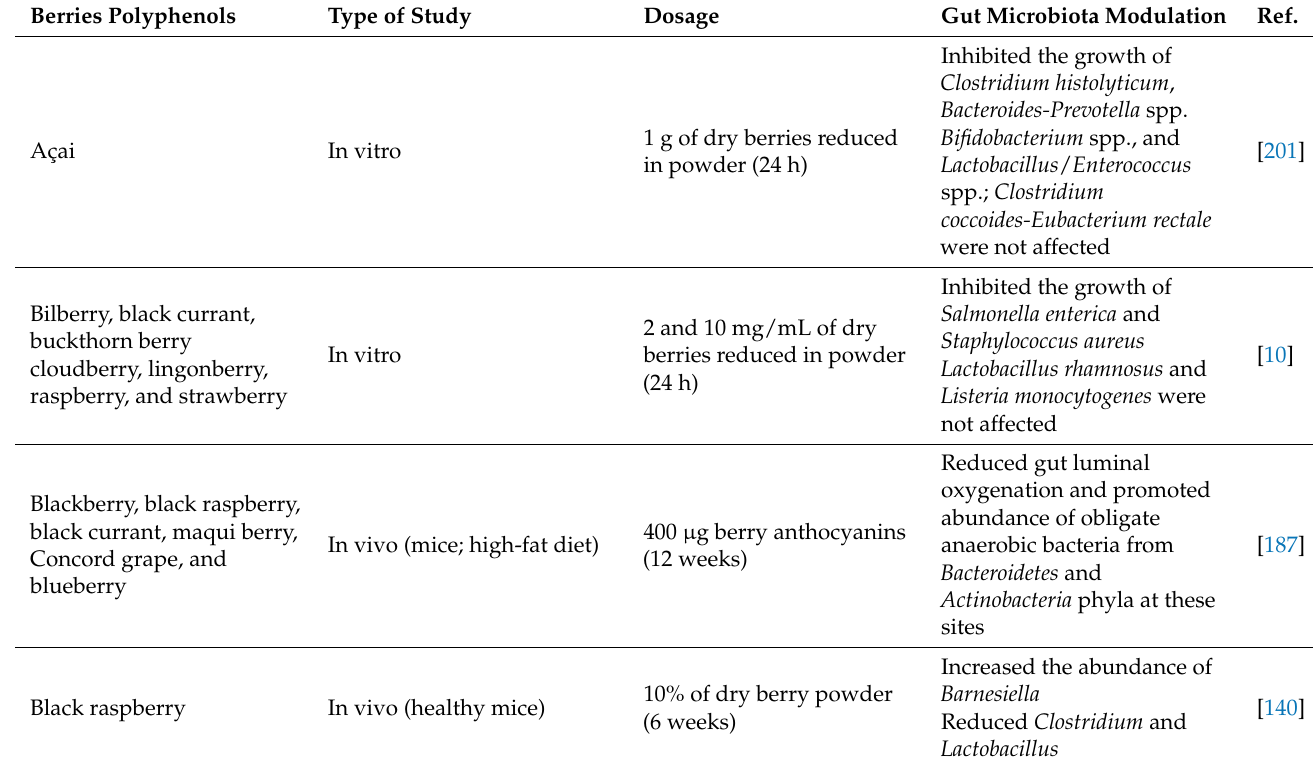
Table 2. Summary of reports concerning the modulation of gut microbiota by berry